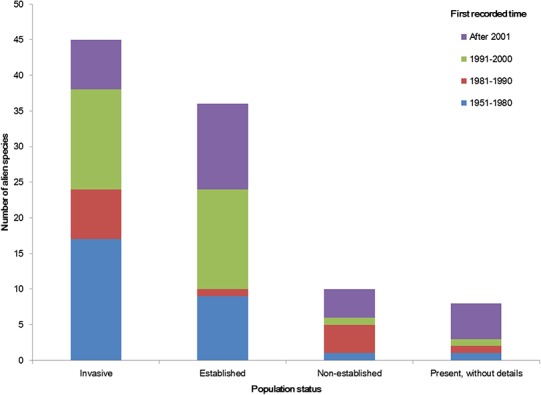
Population status of alien animal species detected in different temporal periods of the past 64 years.The first recorded time of each species was considered to graph the column figure. Species without such data were excluded.